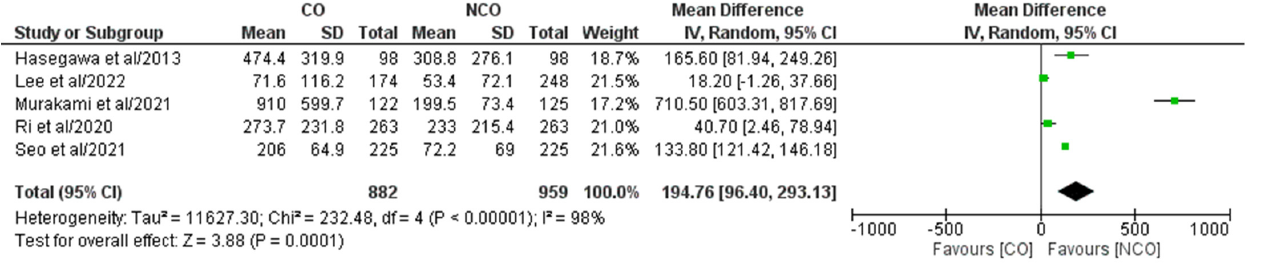
Figure 5. Forest plot comparing estimated blood loss between the CO and NCO groups. CI, confi- dence interval; M–H, Mantel–Haenszel [16,19,21,27,30].